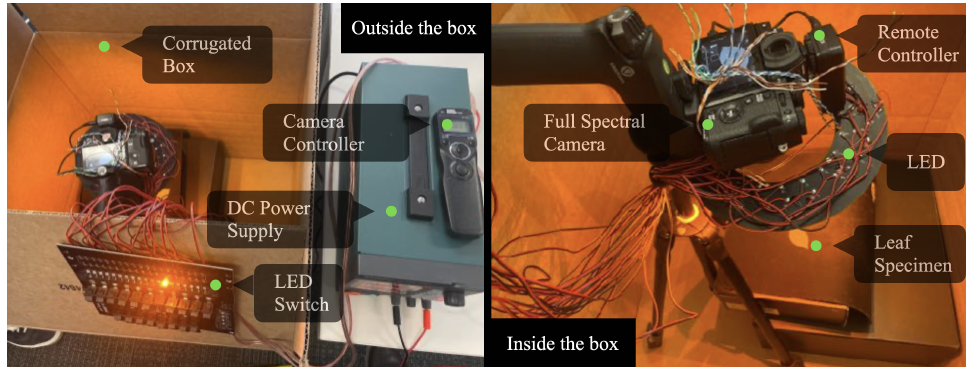
Figure 6. The active hyperspectral experiment setup. The active hyperspectral imaging experiment is carried out in a dark environment. Different components of this experiment setup are marked in the